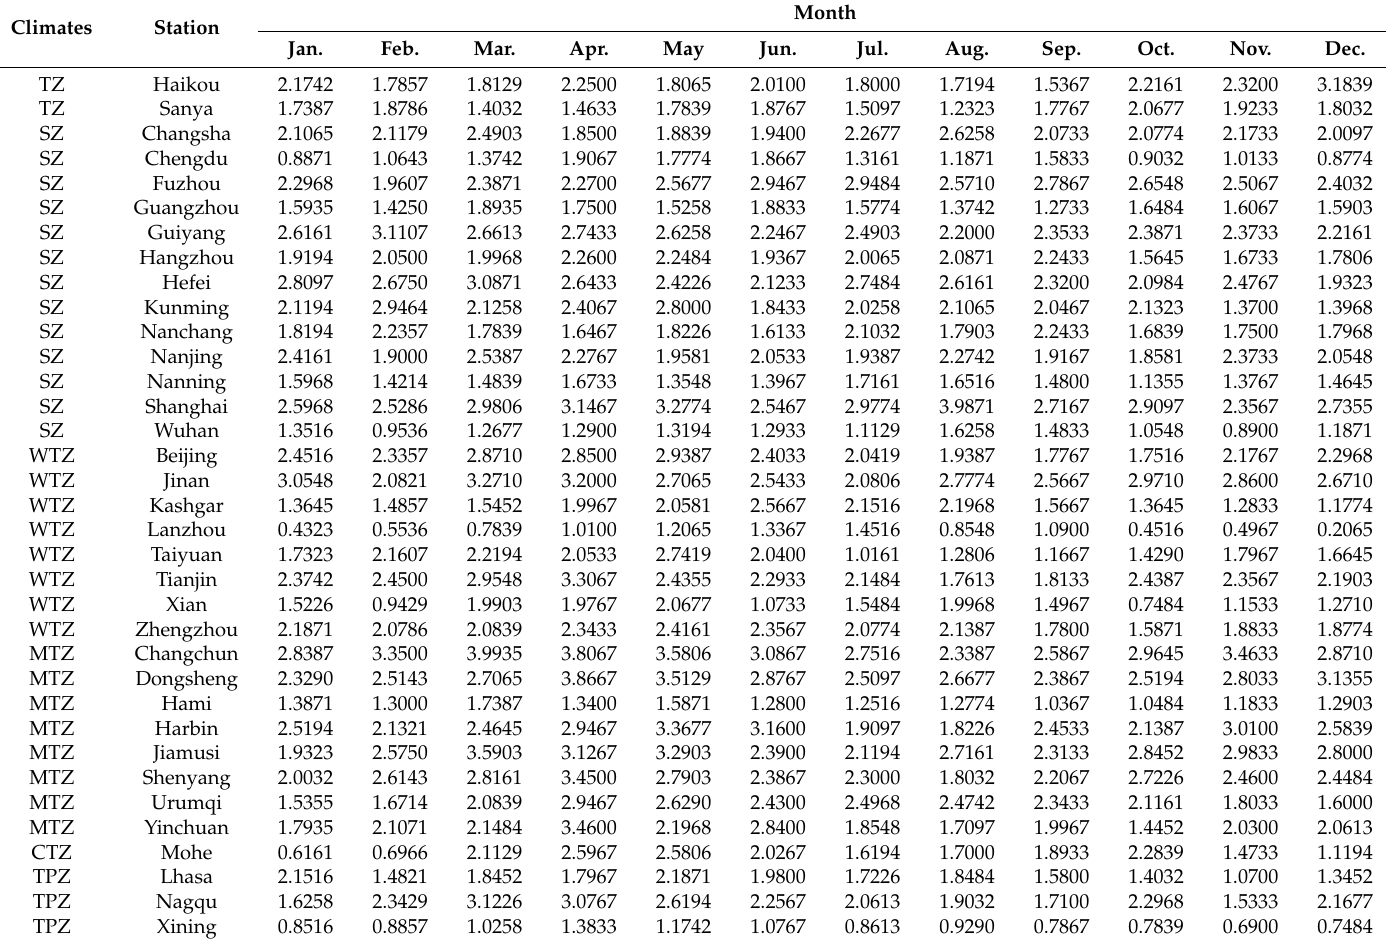
Table A2. Summary of monthly mean wind speed of 35 cities in six different climatic zones of China from the TMYs using the synthetic method. Climates Station